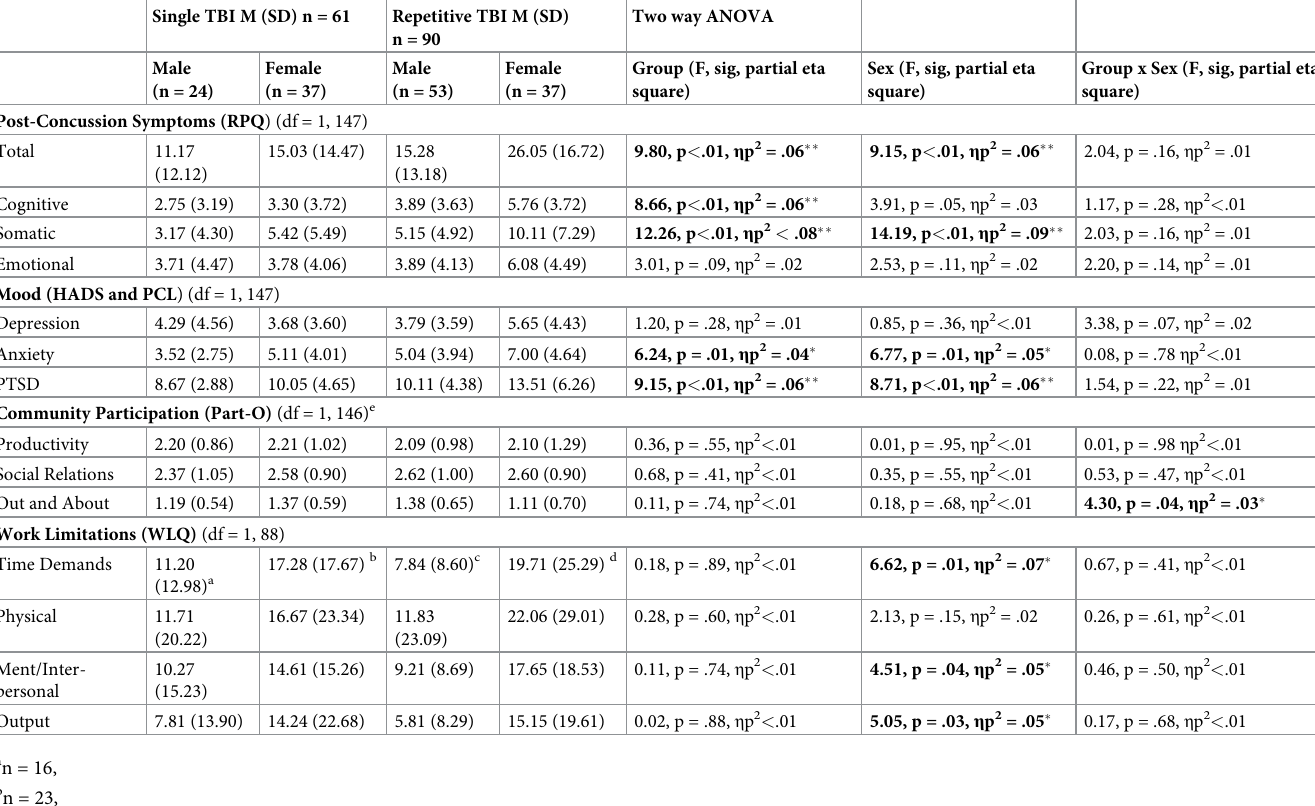
Table 4. Descriptive and inferential statistics for males and female with single or repetitive TBI for each outcome measures. Data are presented as mean (standard deviation) for males and females with a single or repetitive TBI eight years post-injury for measures of symptom and symptom burden and functional outcomes. Two-way ANOVAs were conducted to explore differences by group and